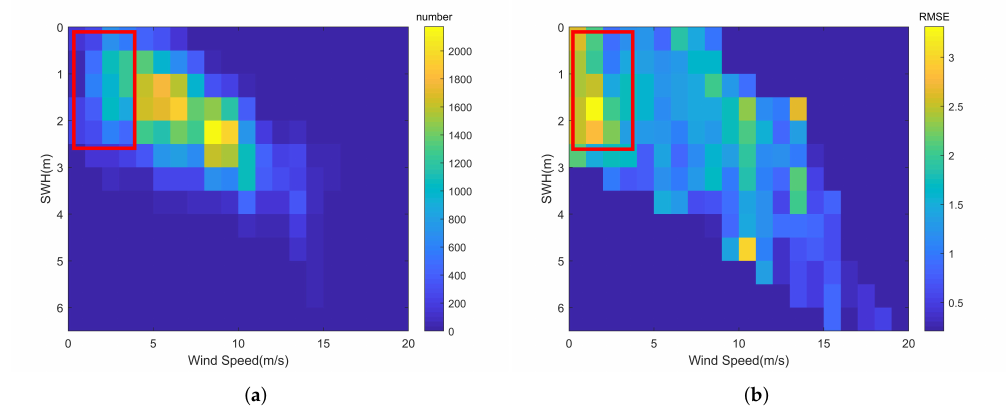
Figure 10. Wind speed–SWH distribution. ( a )the training data set number, ( b ) Wind speed–SWH distribution of the RMSE of the retrieved result (wind